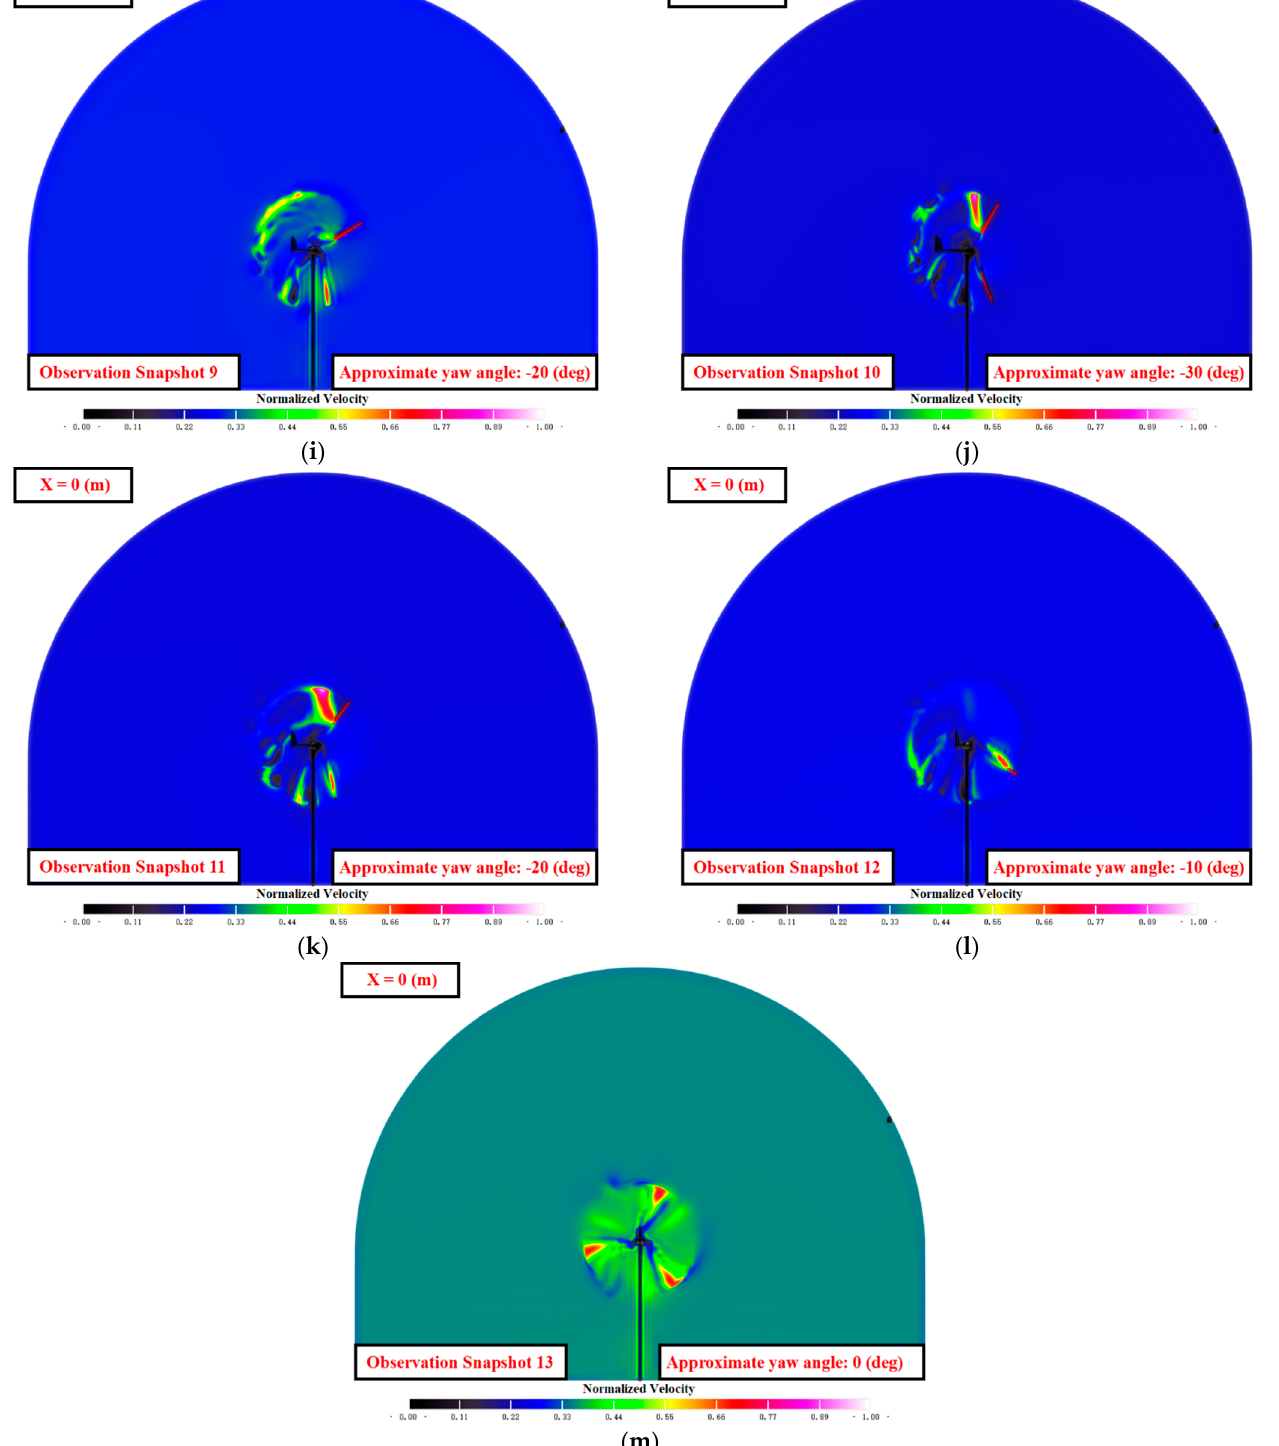
Figure 11. Computational snapshots in the transverse feature surface of X = 0 (m), in which the sub-figures of ( a – m ) corresponds to a series of snapshots of 1 to 13 in Figure 7, and please refer to the red font in each sub-figure for the specific correspondence.